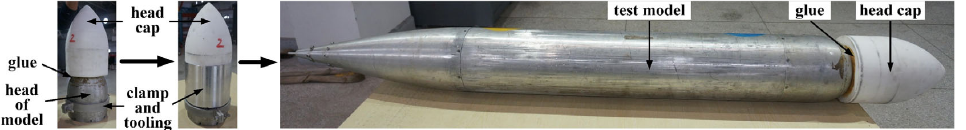
Figure 10. Buffer head caps.